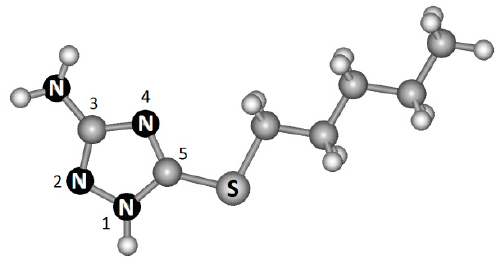
Figure 1. Molecular structure of 5-mercaptopentyl-3-amino-1,2,4-triazole (MPATA).